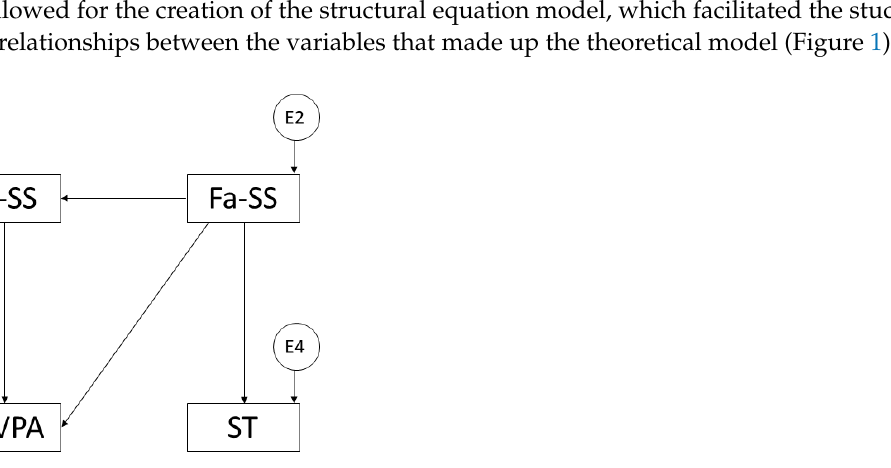
Figure 1. Theoretical model proposed. Note: family support (Fa-SS); friend support (Fr-SS); moderate-vigorous physical activity (MVPA); screen time (ST).